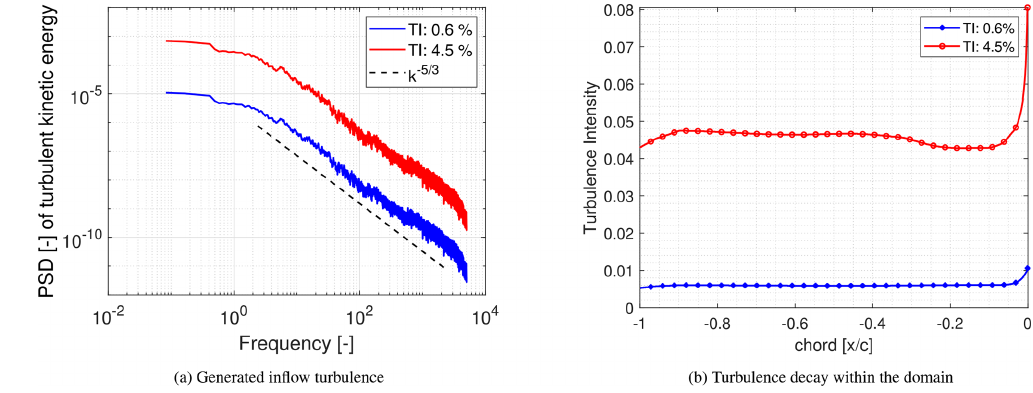
Figure 17. Generated inflow turbulence and its decay within the domain along a line corresponding to the x axis.